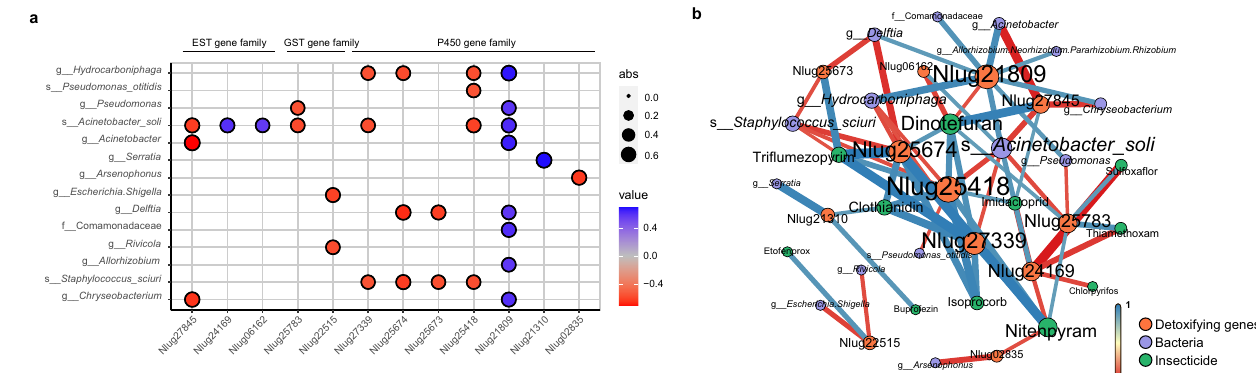
Fig. 4 Microbiome as a potential shaper in detoxifying genes expression of Nilaparvata lugens . a Correlations between detoxifying genes expression and core bacteria abundance. Detoxifying genes are classi fi ed into three intervals by function (P450, GST, and EST, respectively). The size of the node showed the absolute value of correlation, blue means positive correlation, and red means negative correlation. Only genes associated with at least one core microorganism were shown. b Correlation network between key detoxifying genes with insecticide susceptibility and microbial abundance. Correlations are based on Spearman correlation coef fi cients and the node size is positively proportional to its degree, which indicates the number of correlated factors. The line between the two circles indicates a signi fi cant correlation ( P < 0.05), the blue edge line indicates a positive correlation, and the red edge indicates a negative correlation. The thickness of each edge is proportional to the correlation coef fi cient. Detailed information is shown in Supplementary Data